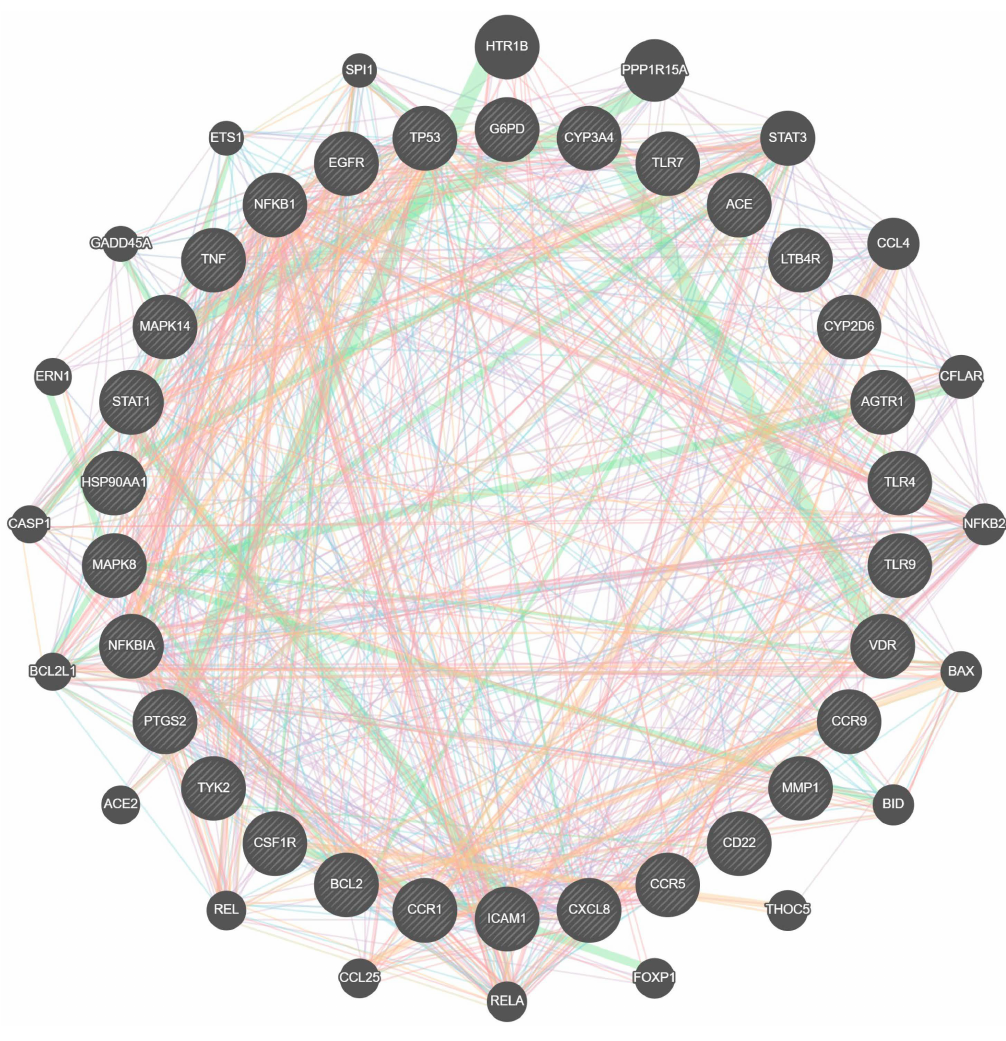
Figure 3. Visualization of COVID-19-associated unique gene interaction. Colored lines between the genes indicate various types of interacting evidence: periwinkle—co-expression; orange—physical interaction; green—genetic interaction; blue—localization; sky blue—involvement in